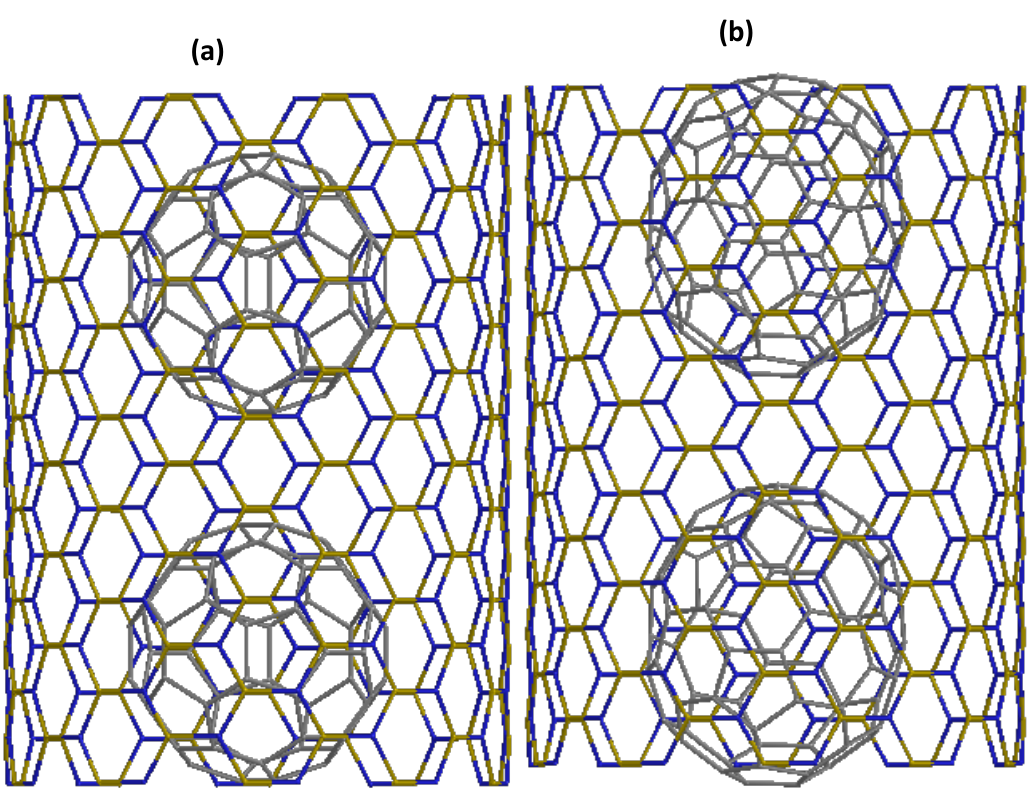
Figure 1. Structure of two SWBNNT peapods: ( a ) C 60 @(10,10) and ( b ) C 70